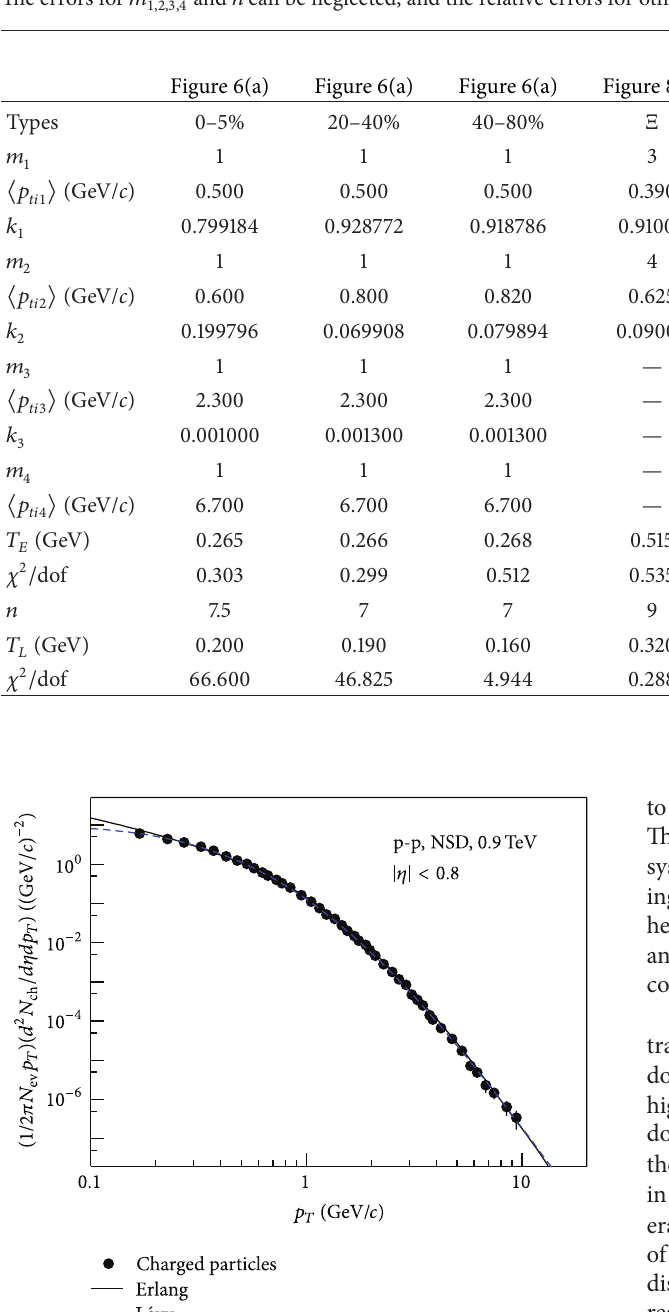
Table 4: Parameter values for the two kinds of curves in Figures 6(a), 8, and 10. The values of 𝜒 2 / dof and extracted temperatures are given. The errors for 𝑚 1,2,3,4 and 𝑛 can be neglected, and the relative errors for other parameters are less than 10%.